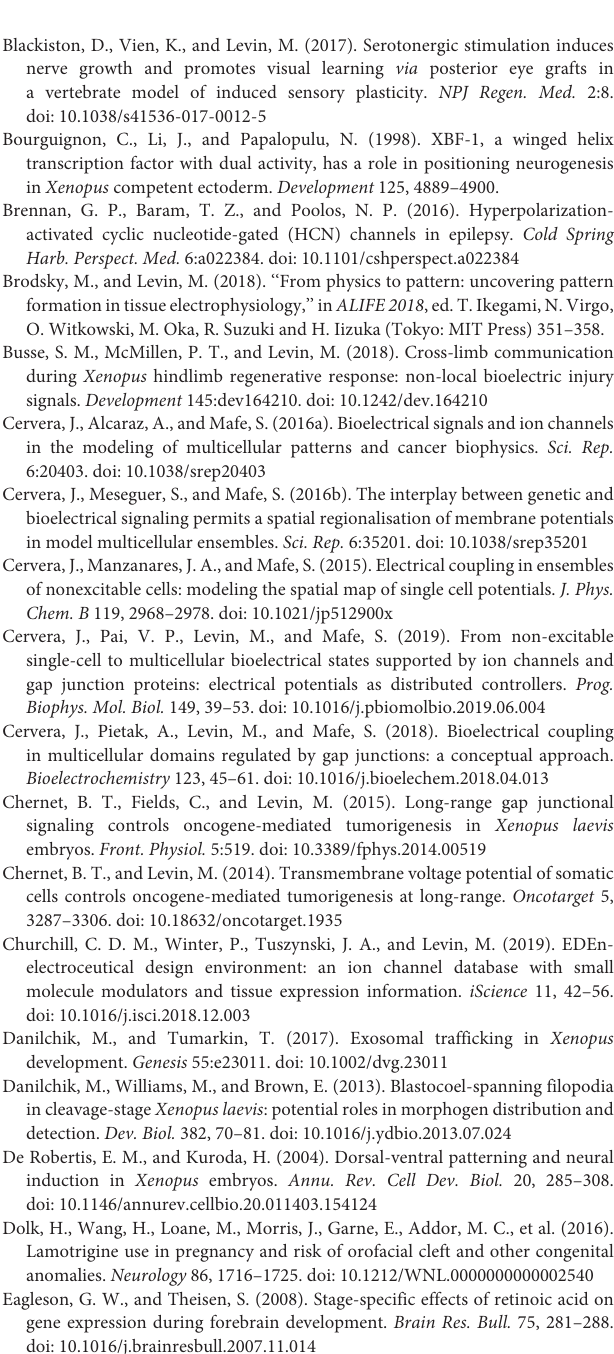
FIGURE S3 | Experimentally, the gap junction conductance G ij / G ref between two neighboring cells i and j follows a bell-shaped function of the difference V i – V j [ left , (A,C) ] which confers the intercellular plasticity [ right , (B,D) ] of the effective nodes in the multicellular ensemble. The curves show two high and low values of the maximum conductance G o scaled to the reference conductance G ref . This maximum intercellular conductance is attained when the two cells are at the same polarized ( red ) or depolarized ( blue ) potentials. In addition to this internal voltage gating affecting the conductance G ij , the maximum conductance G o could also be decreased by blocking the junction with external agents. The junction parameters are the potential V 0 that determines the width of the bell-shaped